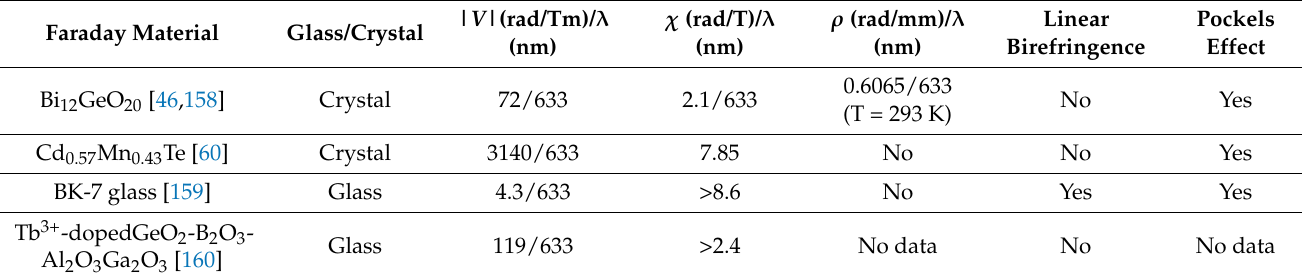
Table 1. Properties of several Faraday materials.